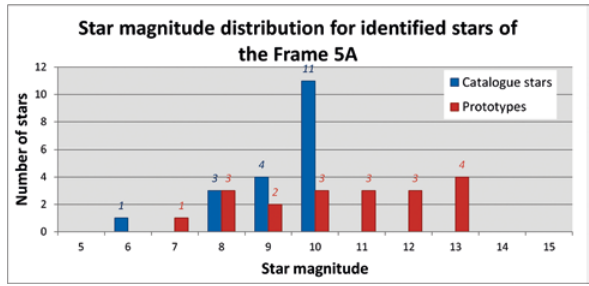
Fig. 2. Comparison of catalogue star magnitudes and assumed star image magnitudes in plate